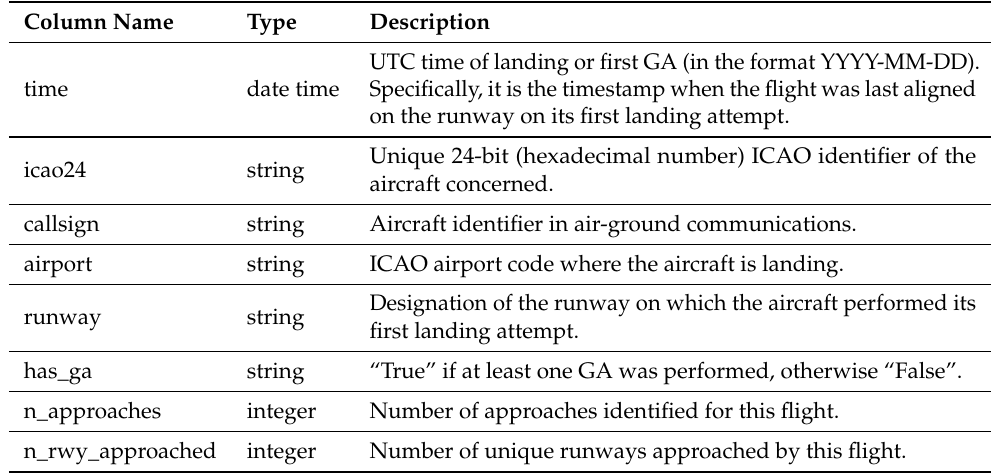
Table 1. Columns in the dataset.